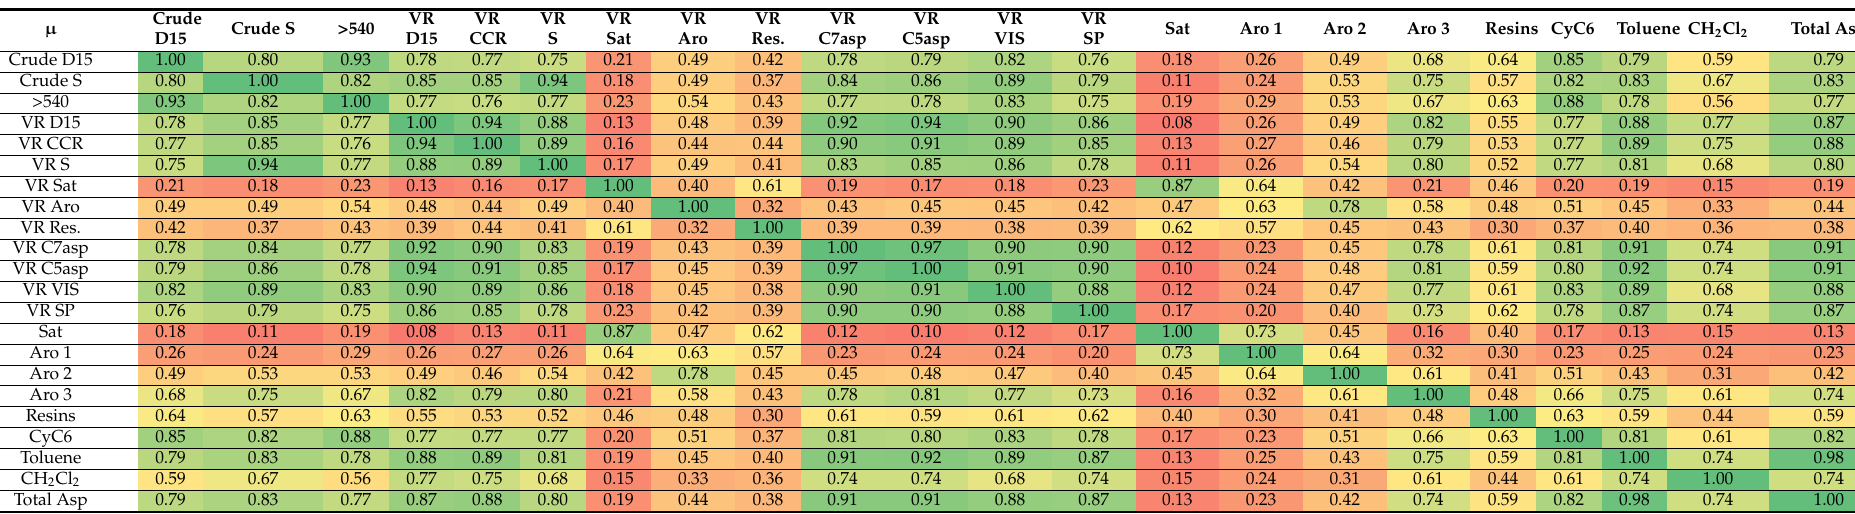
Table 6. µ -Value of the ICrA evaluation of relations between crude oil and vacuum residue bulk properties, LNB SARA, and SAR-AD characteristics.